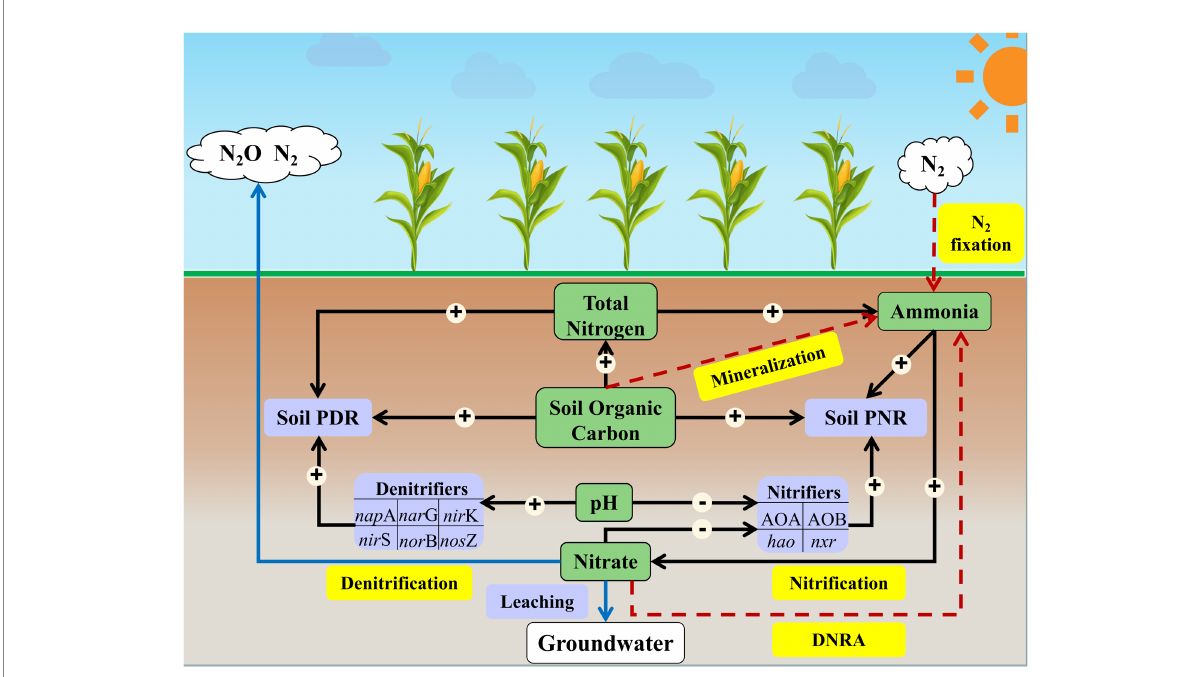
FIGURE 5 Conceptual diagram demonstrating how environmental and biological factors affect soil N transformation processes. The pathways of soil ammonia fixation are indicated by red arrows, and the pathways of nitrogen loss are indicated by blue arrows. The significant direct effects of N-cycling microorganisms and soil properties on soil potential nitrification rate and denitrification rate are indicated by black arrows. The symbols “+” and “ − ” in the circle associated with black arrows represent increasing and decreasing of effect, respectively, on the N transformation process. Soil PNR, soil potential nitrification rate. Soil PDR, soil potential nitrification